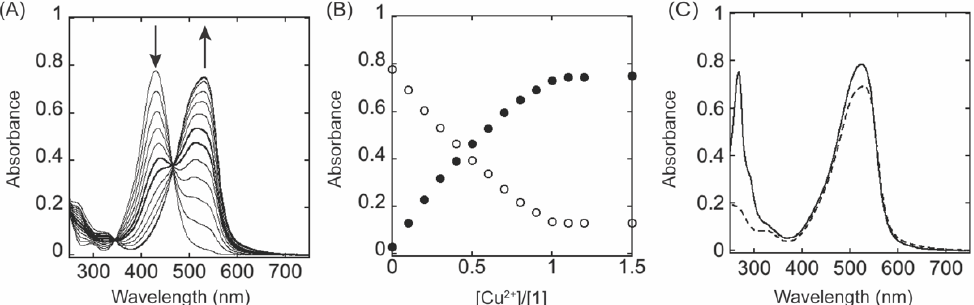
Figure 4. Cu 2+ causes ~100 nm red −shift in λ max of 1 at pH 8.0. ( A ) UV − vis spectral changes of 1 upon titration with Cu 2+ . [1] = 0.02 mM. (B ) The absorbance changes at 430 nm ( ○ ) and 526 nm ( ● ) saturated at [Cu 2+ ]/[1] = 1. ( C ) The comparison of the final spectrum of 1 titrated with Cu 2+ ( ––– ) and 1 mixed with an equal amount of dichloro(1, 10 − phenanthroline)Cu(II) ( ).